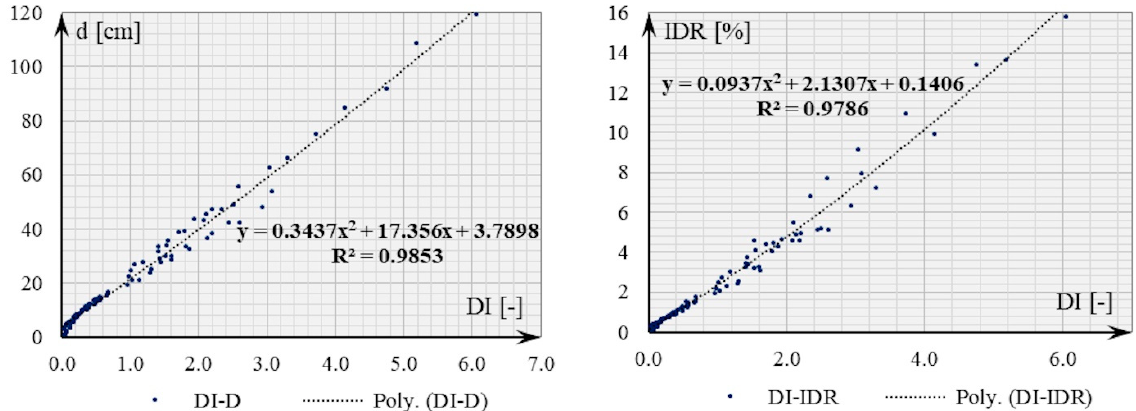
Figure 13. Relationship between DI and d ( left ) and DI and IDR ( right ). Table 2. Structural damage state threshold